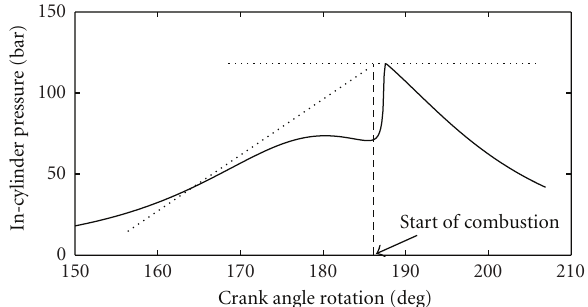
Table 2: Inlet parameters